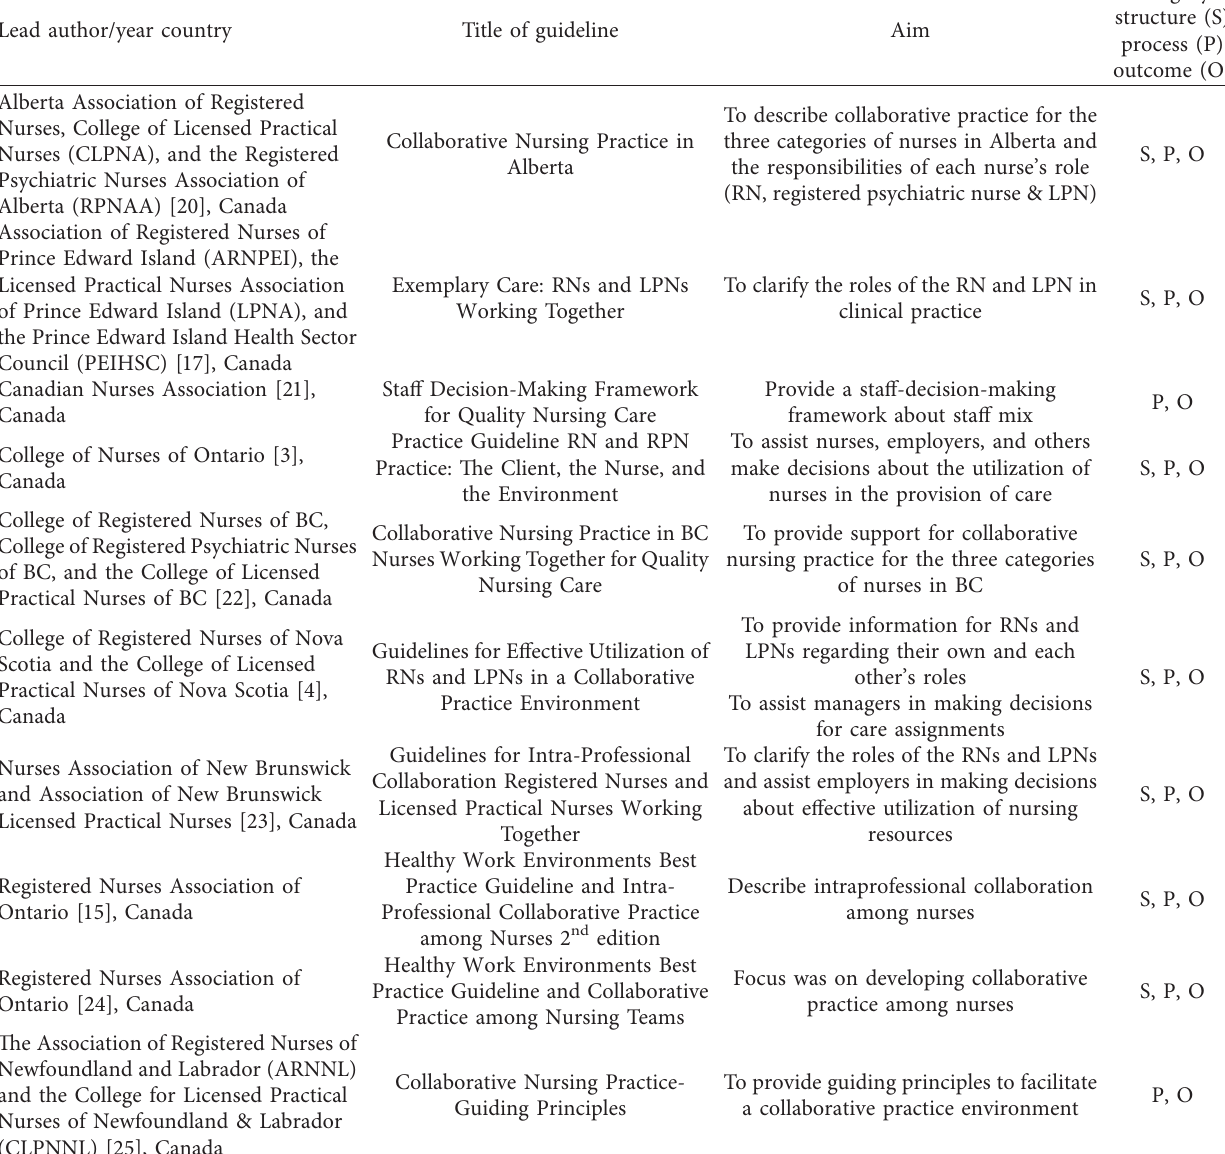
Table 1: Summary of